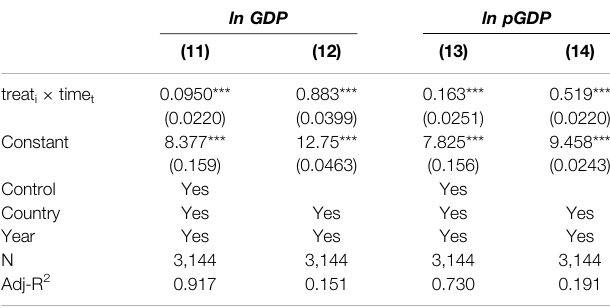
TABLE 5 | Results of PSM-DID regression.